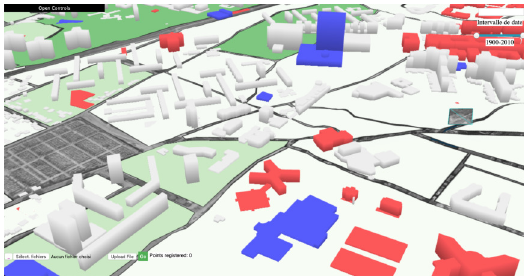
Figure 3. Co-visualization of 3D buildings (red: commercial, blue: public and remarkable, white: undifferentiated), statistical vector data, geolocalized oblique images and